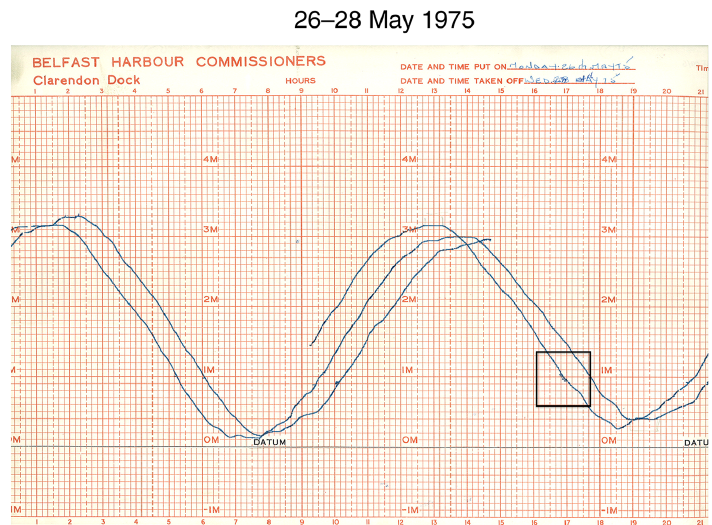
Figure 3. Tide gauge recordings at Belfast harbour 26–28 May 1975. Minor oscillations can be seen upon close inspection at approximately 17:00. Retrieved through personal contact with the Permanent Service for Mean Sea Level (2016) (Holgate et al.,